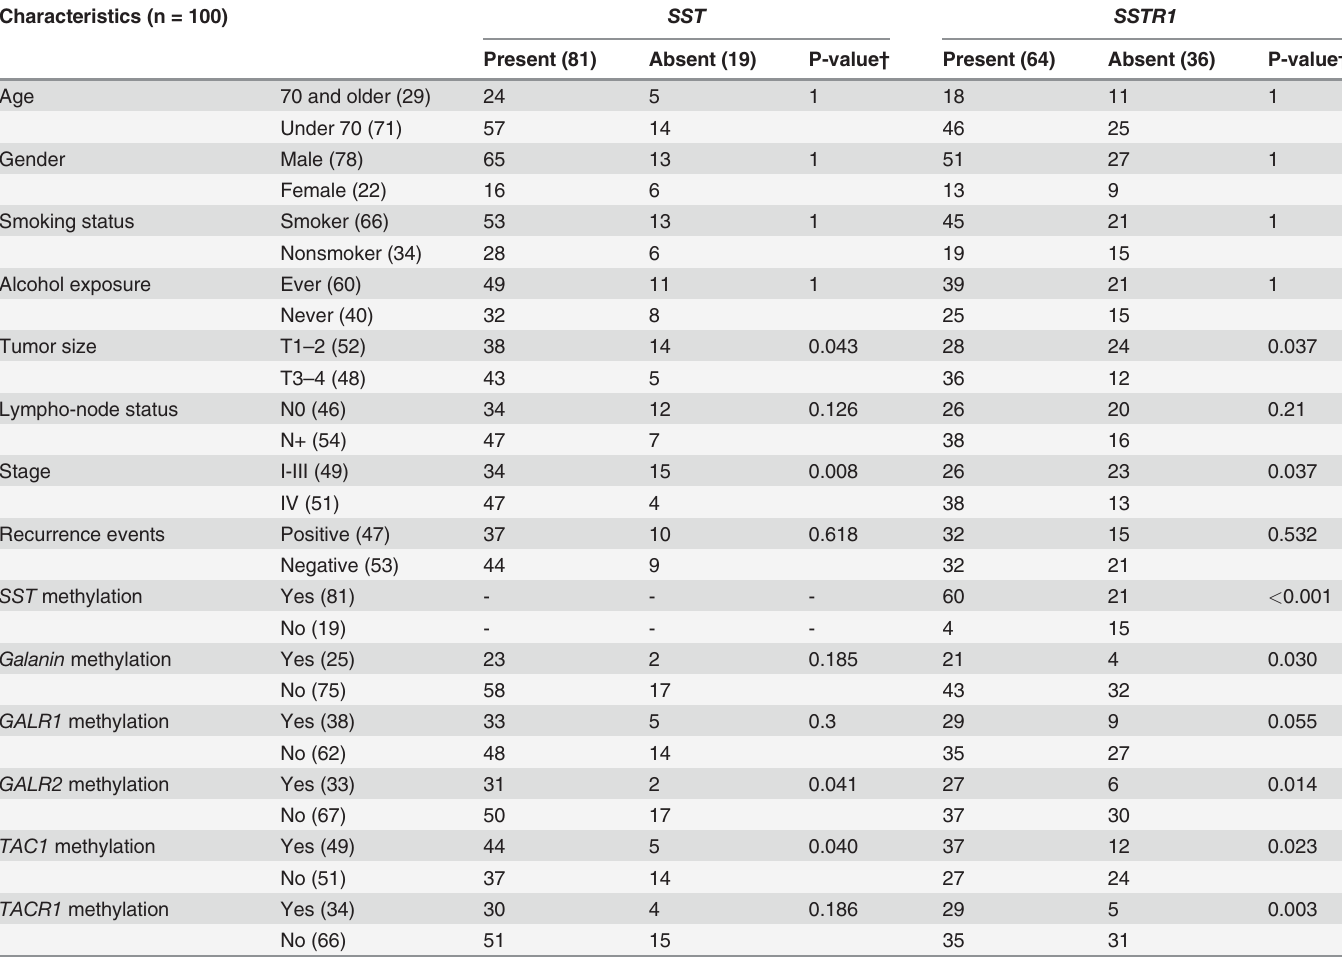
Table 1. SST and SSTR1 Genes Methylation Status in HNSCC Primary